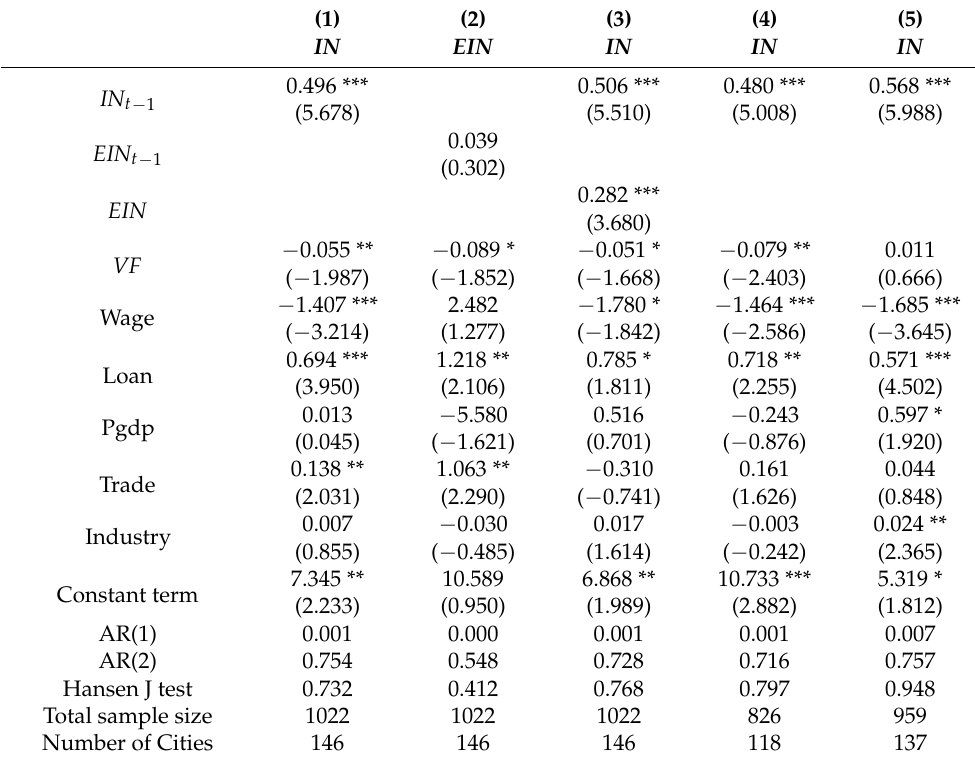
Table 4. Mechanism test and heterogeneity